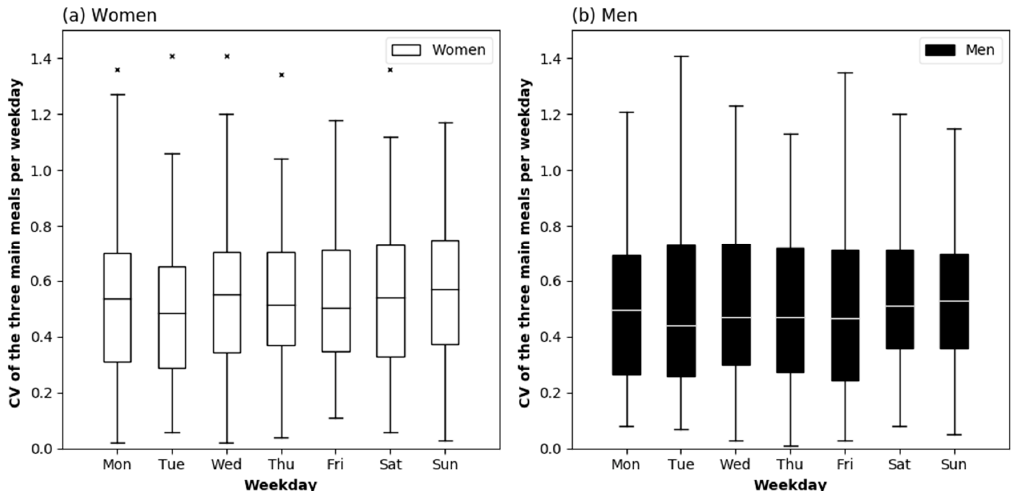
Figure 3. Protein distribution across the day expressed as coefficient of variation (CV) between three main meals by weekday in healthy community-dwelling older women ( n = 72) ( a ) and men ( n = 68) ( b ). Friedman’s test: p = 0.350 in women, p = 0.147 in men. The boxes represent interquartile ranges with the horizontal lines denoting the median. The whiskers show the highest and lowest values within the 1.5-fold interquartile range. The × represent outliers.